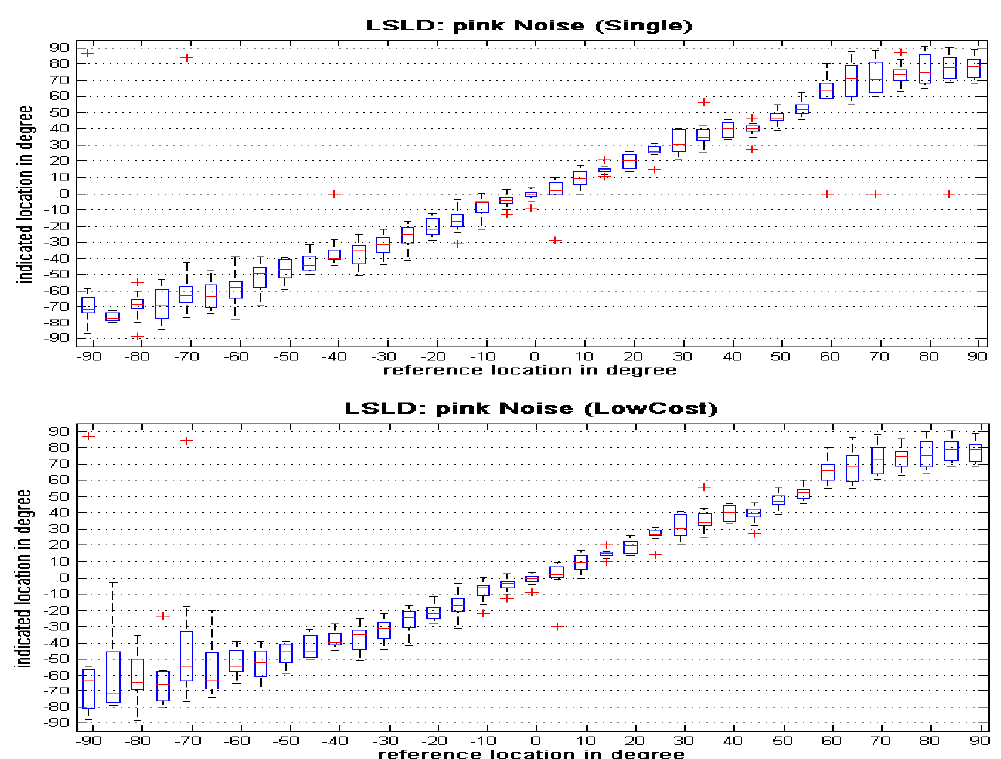
Figure 5. Representation of the localization performance; stimulus used was “Pink Noise”. The results are shown as boxplots (median value, the 75%- and the 25% -quartile, as well as the inner limitation reference to the boxplots). The outliers are shown with a “+”. Top: Results with SingleCam; Bottom: Results with low-cost